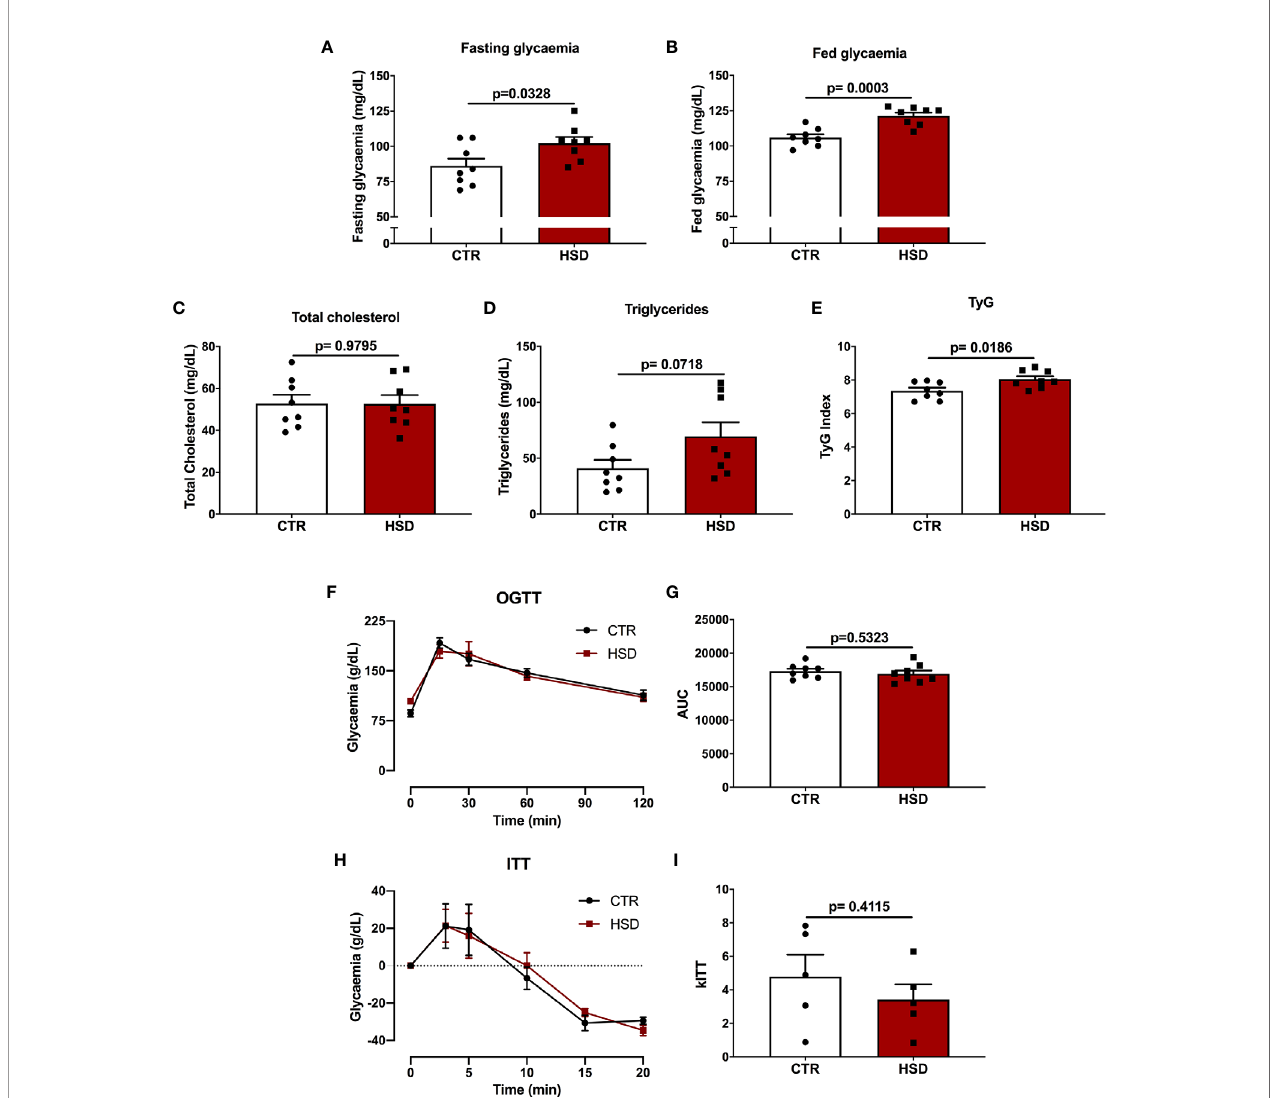
FIGURE 2 | High-sucrose diet (HSD) alters glucose metabolism and causes insulin resistance in female rats. (A) Fasting glycaemia was calculated as time 0 of OGTT. (B) Fed glycaemia was calculated as time 0 of ITT. (C) Total cholesterol and (D) triglycerides were measured in fasting rats upon euthanasia (pnd 120). (E) TyG Index was calculated as described in Materials and Methods. (F) Glucose tolerance test (OGTT) was assessed in 8-hour fasted rats at times 0, 15, 30, 60 and 120 min. (G) Area under the curve (AUC) of OGTT. (H) Insulin tolerance test (ITT) assessed in fed animals at times 0, 3, 5, 10, 15 and 20 min. (I) kITT calculated as described in Materials and Methods. n=5-8 animals in each group. Graphs express mean ± SEM and bar graphs show individual values. P-values are shown in bar graphs and were calculated using unpaired Student